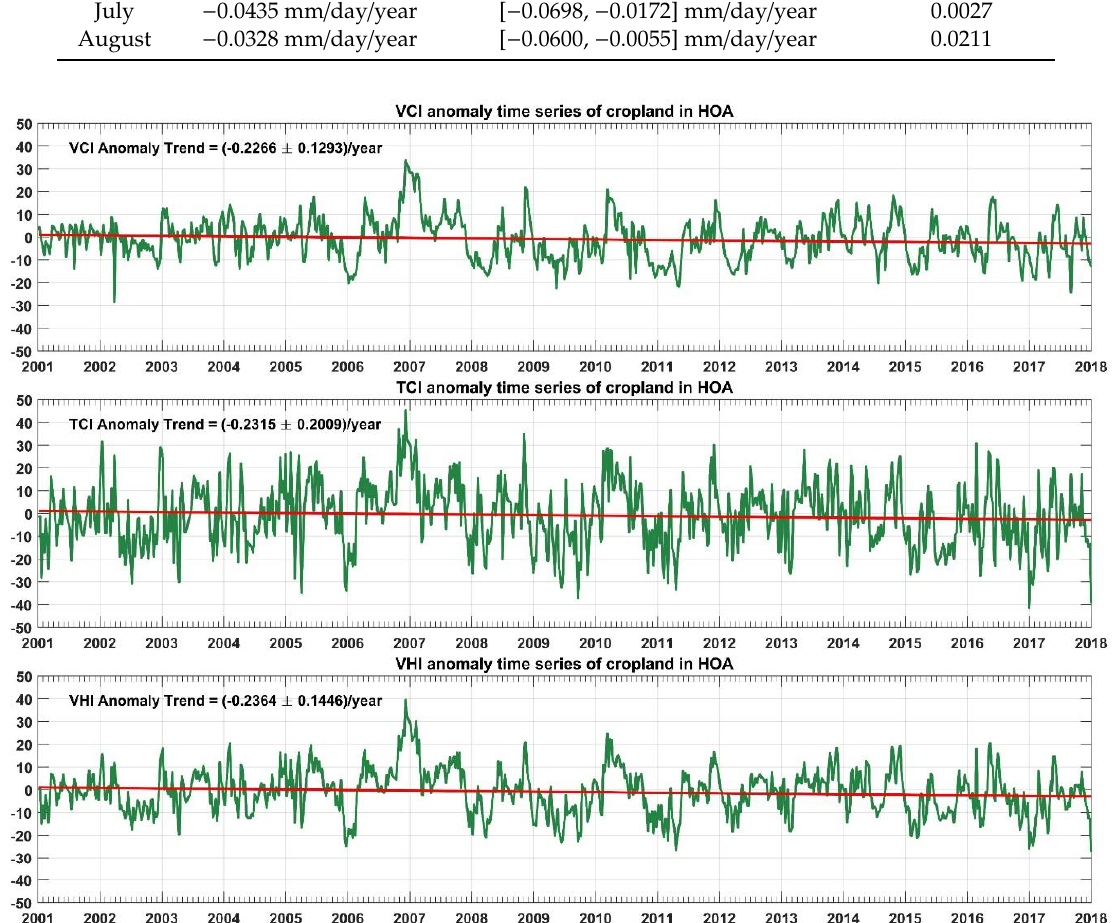
Figure 8. VCI (top), TCI (middle), and VHI (bottom) anomaly time series of cropland in the HOA from the years 2001 to 2017. The red lines are trend lines.